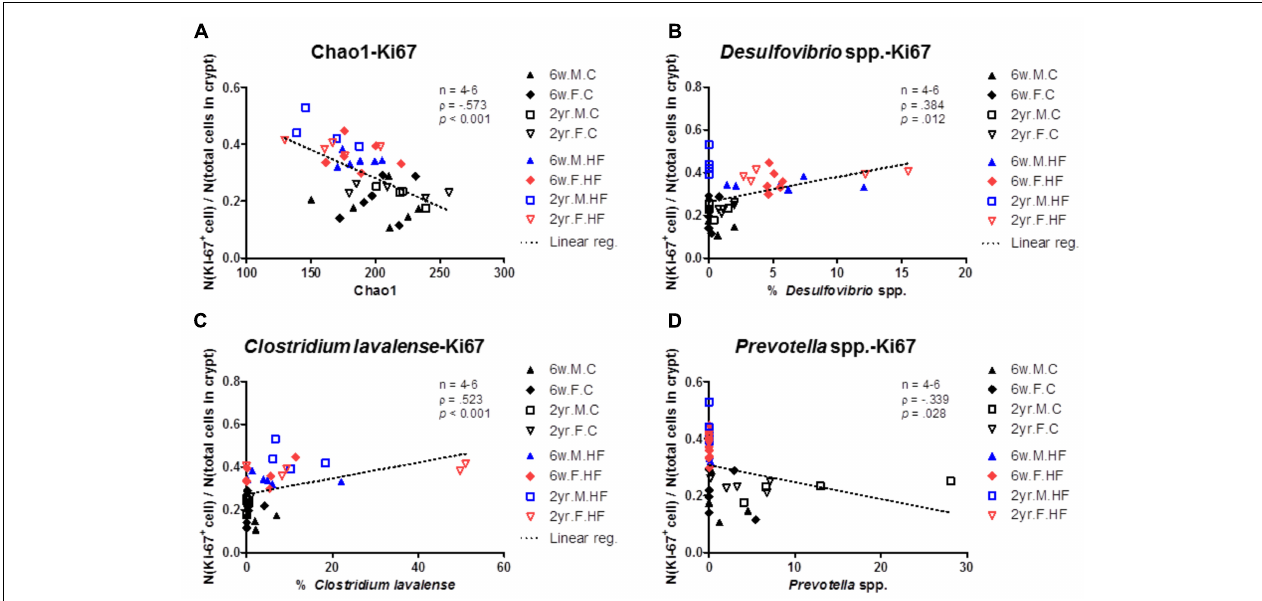
FIGURE 6 | Correlation between gut microbiome and cell proliferation index. Species richness (Chao1) (A) , abundance ratios (%) of Desulfovibrio spp. (B) , Clostridium lavalense (C) , and Prevotella spp. (D) were significantly correlated with cell proliferation index of colonic mucosa (N(Ki67 + cell)/ N (total cells in crypts). p < 0.05 to Spearman’s correlation (A–D) . Dotted line indicates the regression line. The correlations were analyzed with Spearman’s rank correlation coefficient method (also known as Spearman’s rho) and linear